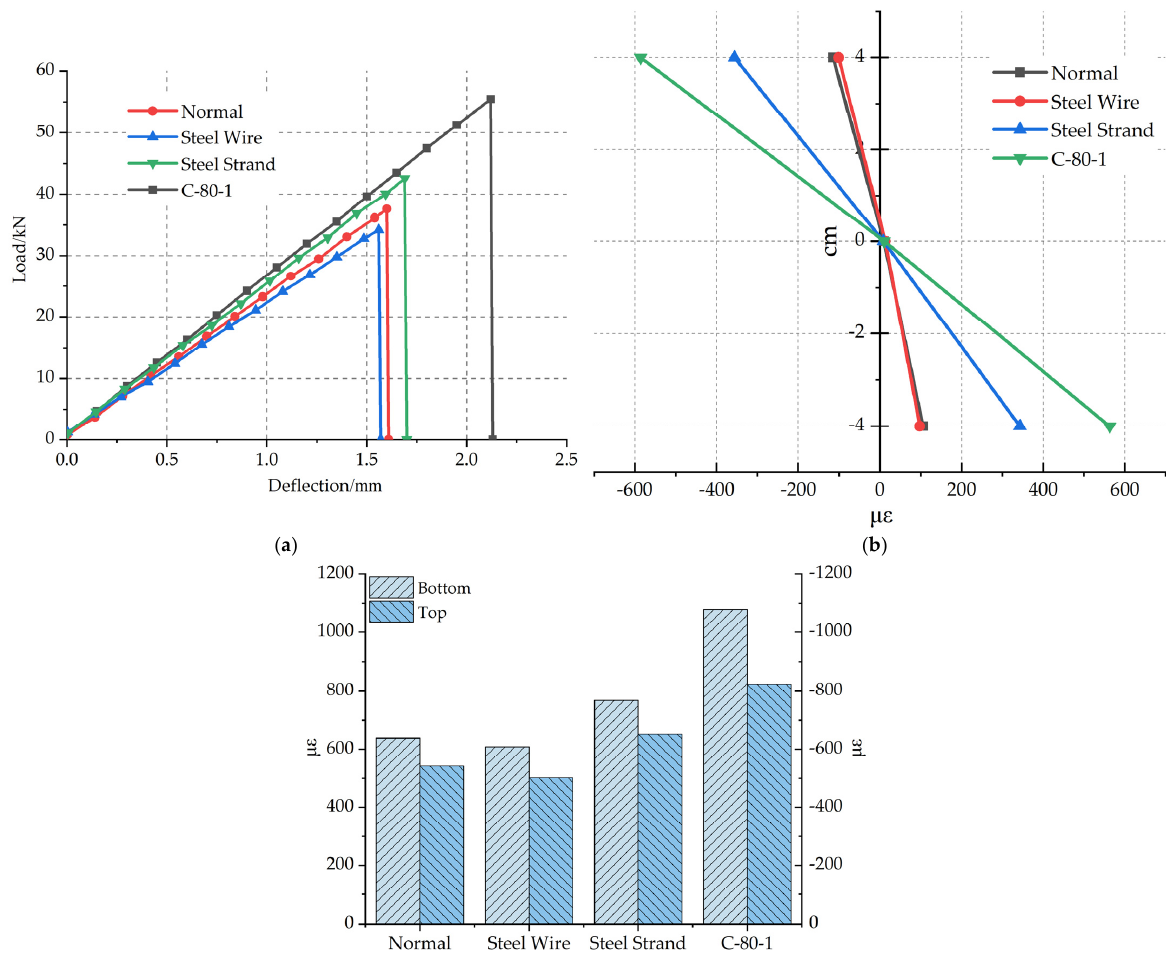
Figure 13. ( a ) Load–deflection curves of different reinforced materials. ( b ) Failure strain of different reinforced materials along the beam height. ( c ) Failure strain of beam bottom and top of different reinforced materials.